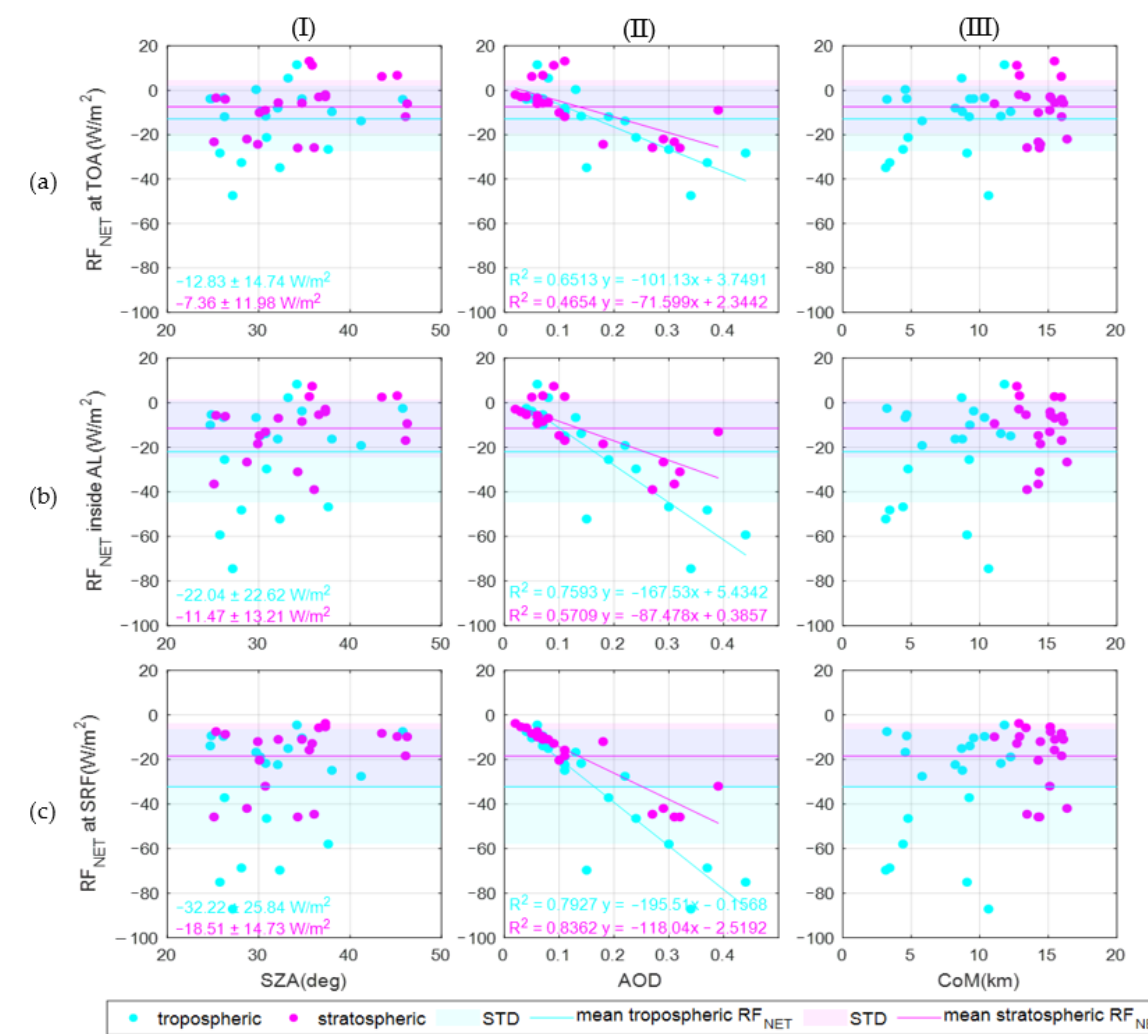
Figure 7. Net radiative forcing values per case (illustrated by colored solid circles) at top of atmo- sphere (TOA) ( a ), inside the smoke layers ( b ), and at surface (SRF) ( c ), versus the SZA ( I ), the AOD ( II ), and the CoM ( III ) of the aerosol layers. The different colors correspond to the tropospheric (cyan) and stratospheric (magenta) BB aerosol layers, while the solid lines and shadowed areas correspond to the mean values and std of the RF NET at TOA inside the layer and at the SRF.